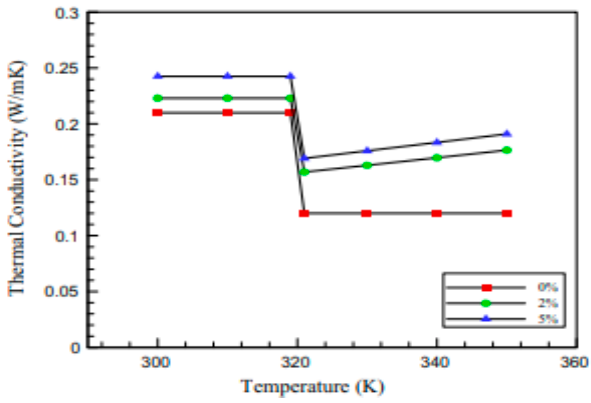
Figure 10. Comparison of the thermal conductivity of a PCM incorporated with nano-architecture (0%, 2%, 5% of Al 2 O 3 ) [107].